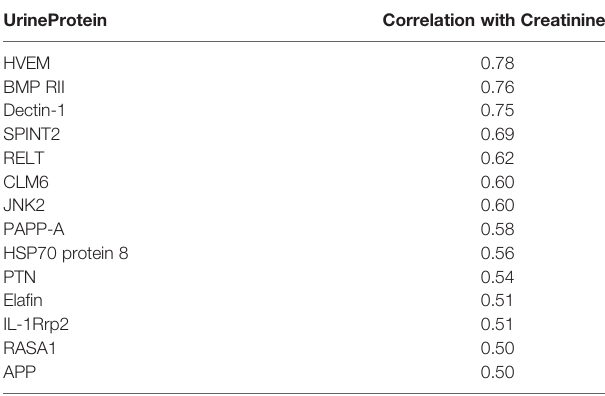
TABLE 2 | Urine proteins that were positively correlated with urinary creatinine but were invariant between LN patients and healthy controls.